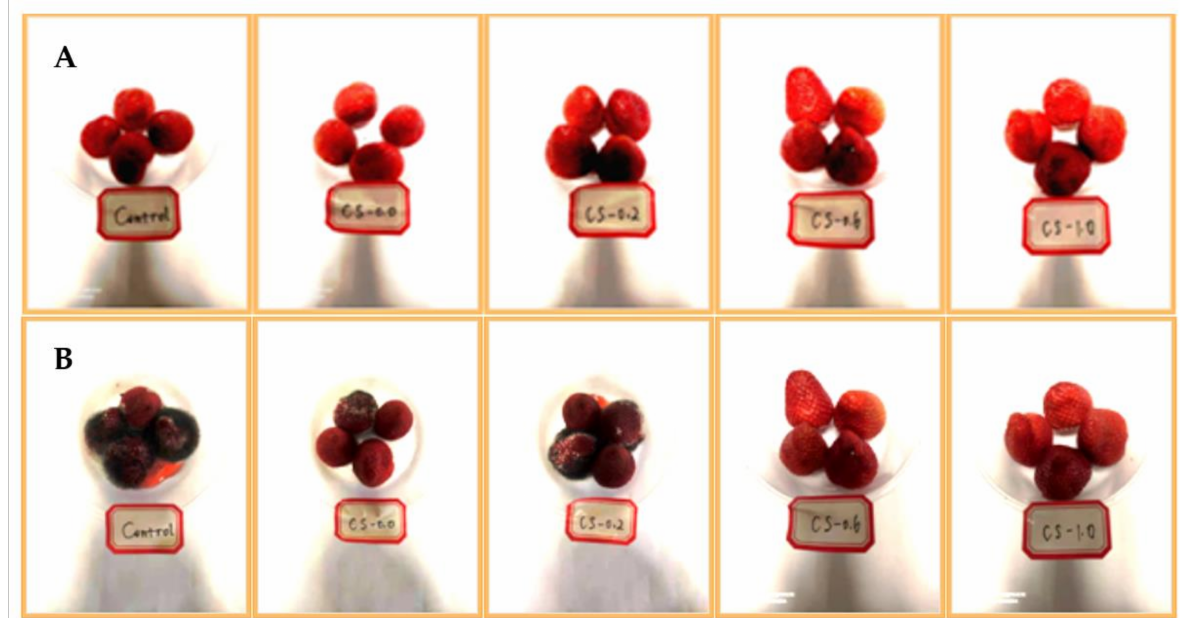
Figure 1. Photographs of strawberries during the refrigeration storage. ( A ): Day 0, ( B ) Day 10. Control, strawberries packed without CS films; CS-0.0, strawberries packed with CS film CS-0.0; CS-0.2, strawberries packed with CS film CS-0.2; CS-0.6, strawberries packed with CS film CS-0.6; CS-1.0, strawberries packed with CS film